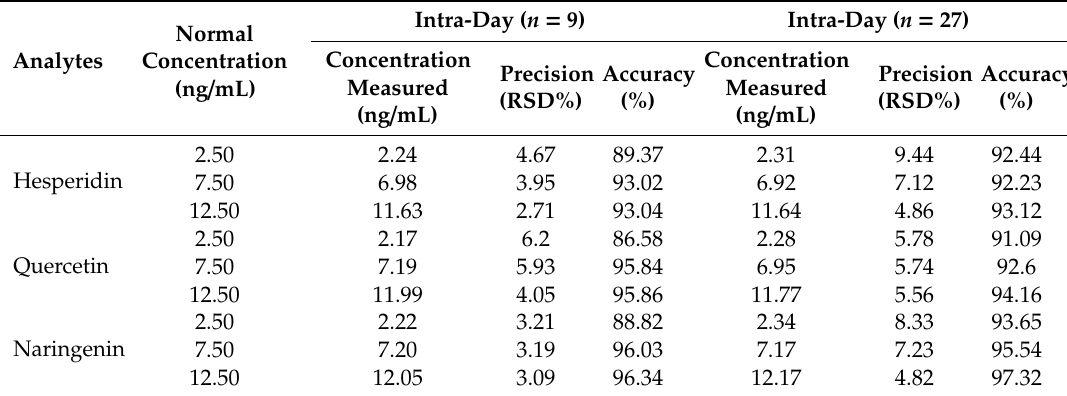
Table 2. Intra-day and inter-day precision and accuracy.